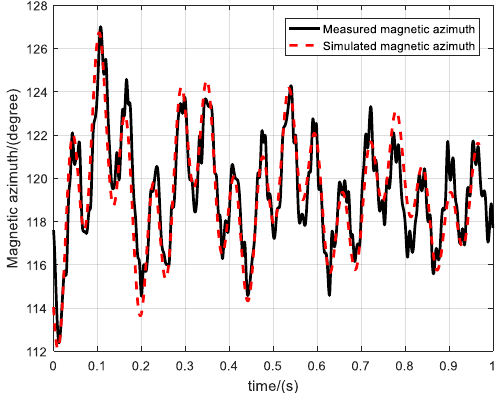
Figure 16. Initial Figure 16. Initial alignment.